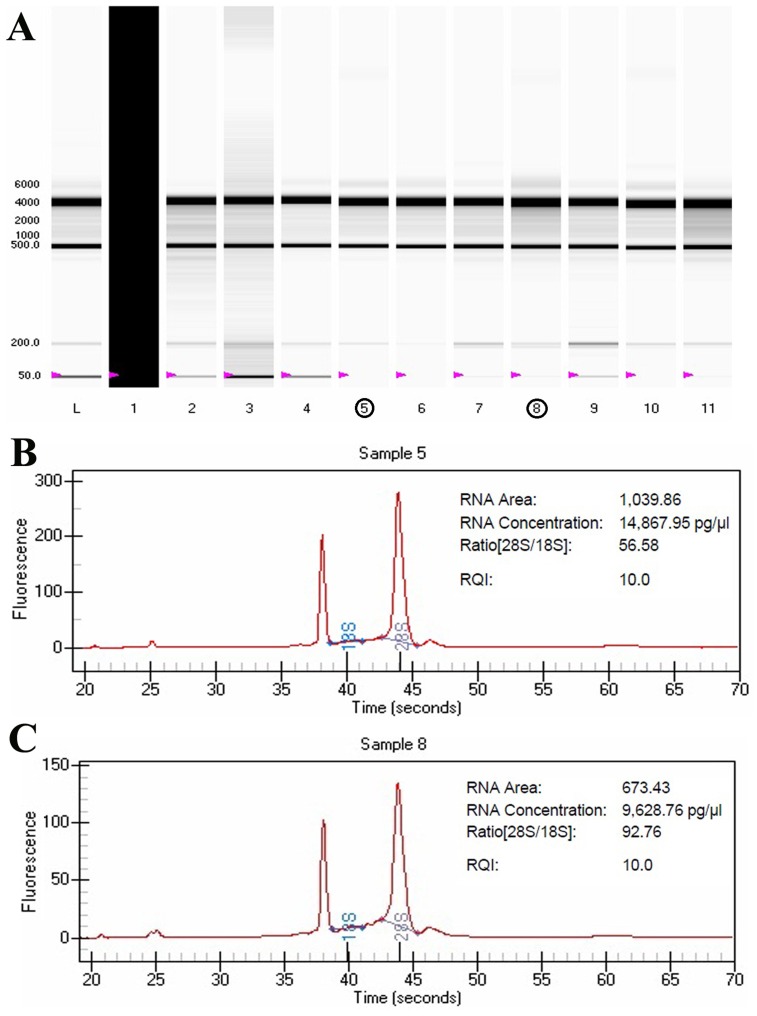
RNA quality and integrity.(A): virtual gel image showing Lane L: RNA ladder, Lane 1: no RNA sample, lanes 2–12 samples. Sample 5 and 8 were for the control and TAF273-treated cells, respectively. (B): electrophoregram for control sample; (C): electrophoregram for TAF273-treated sample.